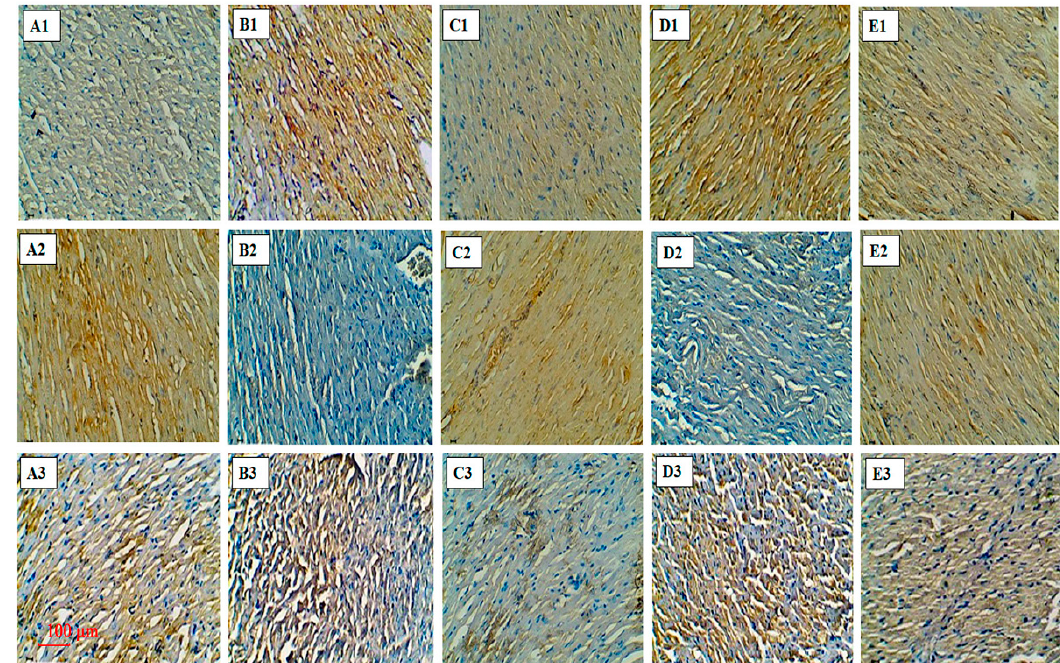
Figure 6. Effects of apigenin on expression of B-cell lymphoma 2 (Bcl-2), Bcl-2 associated X (Bax) proteins and terminal deoxynucleotidyl transferase dUTP nick end labeling (TUNEL)-positive cells in STZ–isoproterenol-treated rats. Immunohistochemical analysis of Bax (A1–E1) and Bcl-2 (A2–E2);